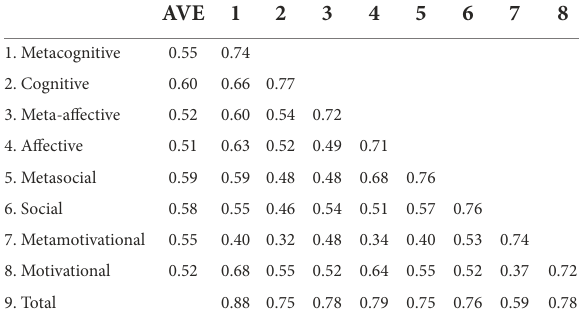
TABLE 2 Average variance extracted (AVE) and correlation coefficients for the SRFLLSQ questionnaire